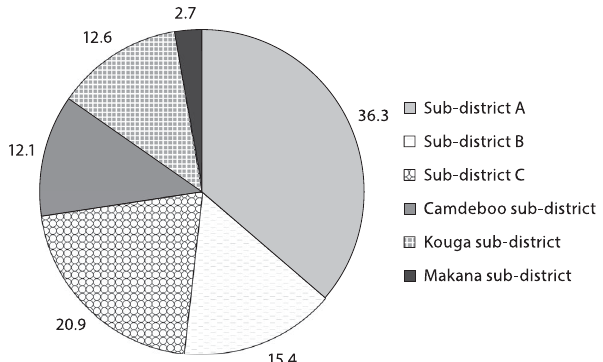
Figure 1: Percentage distribution by sub-district of laboratory-con fi rmed cases of acute hepatitis A for the Nelson Mandela Bay (subdistrict A, B and C with a combined population size of approximately 1 200 000) and Sarah Baartman districts (subdistricts Camdeboo, Kouga and Makana with a combined population size of approximately 470 000). Table 1: Demographic characteristics for children presenting with acute hepatitis A